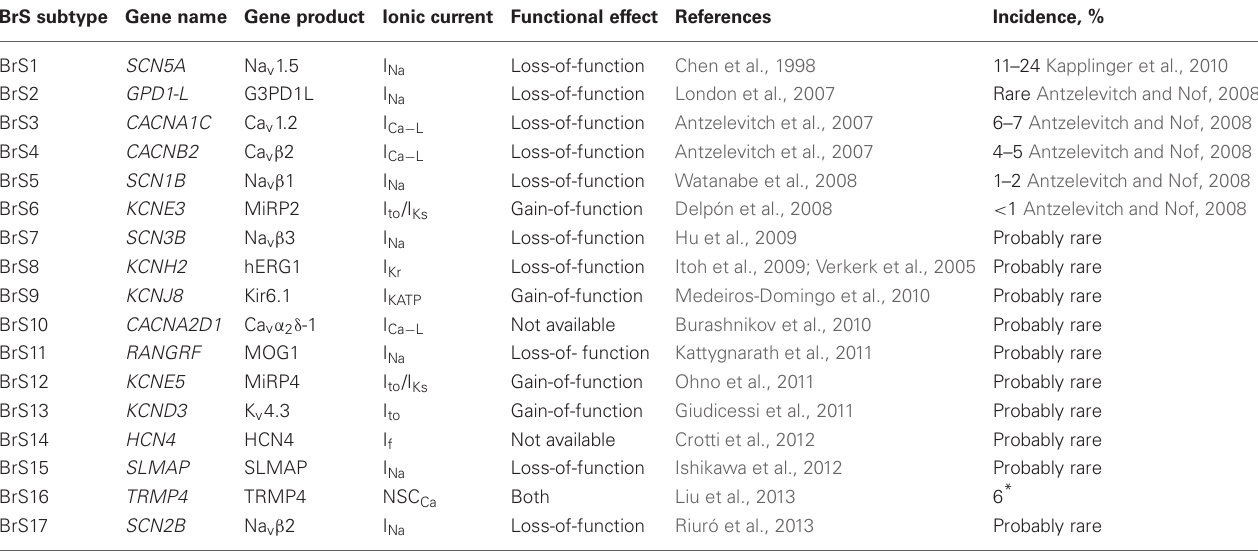
Table 1 | Mutations in genes associated with Brugada